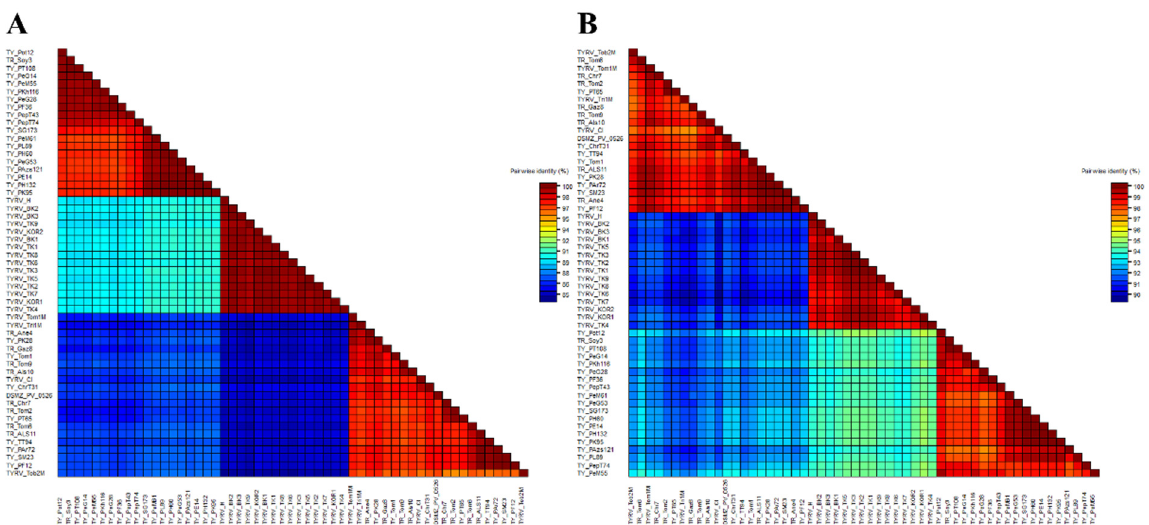
Figure 2. Two-dimensional visualization of nucleotide ( A ) and amino acid ( B ) nucleocapsid (N) protein gene sequence identity of 55 tomato yellow ring virus (TYRV) isolates used in this study. The matrices were performed using SDTv1.2.